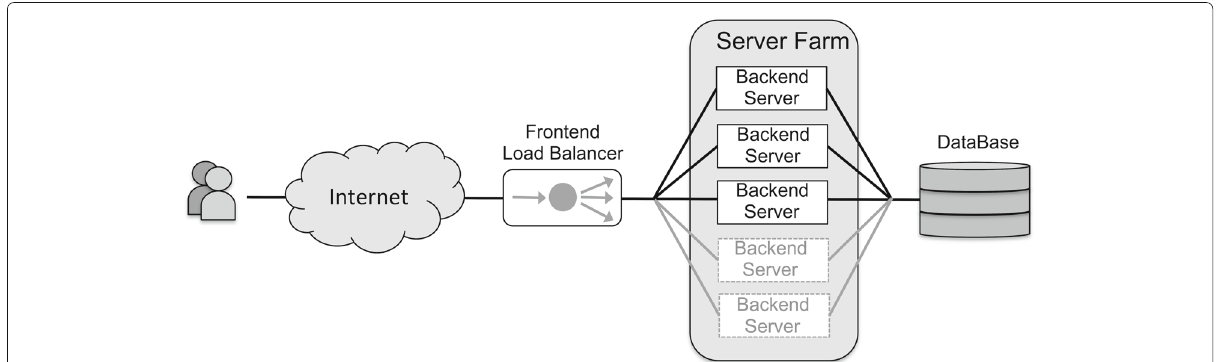
Fig. 1 Elastic cloud service. This figure represents a typical elastic web server cluster, consisting on a service front-end, acting as load balancer, and a variable number of backend servers that process users requests. The cloud auto-scaling mechanisms allow to dynamically adapt the system to workload changes, by autonomously provisioning and deprovisioning resources (i.e., back-end servers), so that at each point in time, the